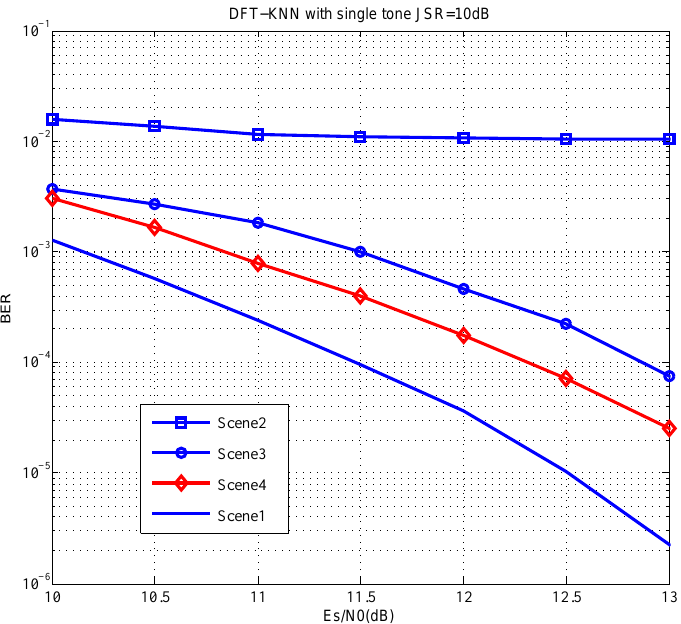
Figure 5. BER in different interference suppression schemes.